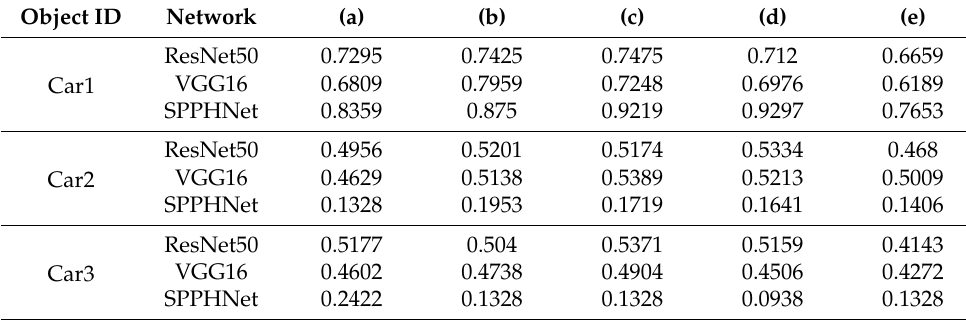
Table 1. Feature distance comparison results of ResNet50, VGG16, and